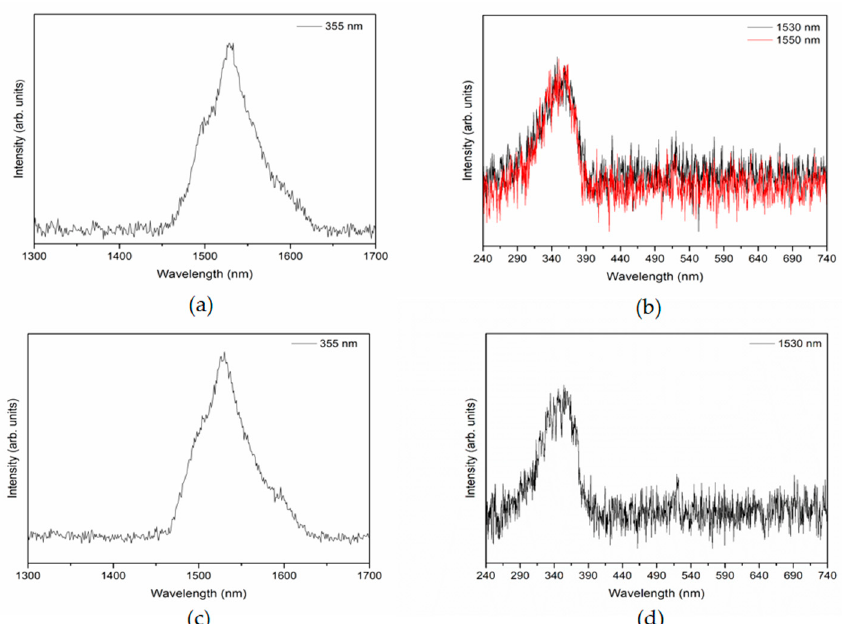
Figure 8. Emission ( a and c ) and excitation ( b and d ) spectra of the glass/IMO/d-PCL(530) 9.1 LiTrif m - [Er(tta) 3 (H 2 O) 2 ] (top) and glass/IMO/WO 3 /d-PCL(530)/siloxane 9.1 LiTrif-[Er(tta) 3 (H 2 O) 2 ] (bottom) plates.